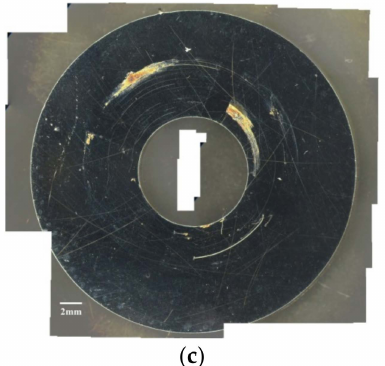
Figure 2. Surface morphologies of the corroded region after 5000 h tests with 0.1 g / m 2 chloride